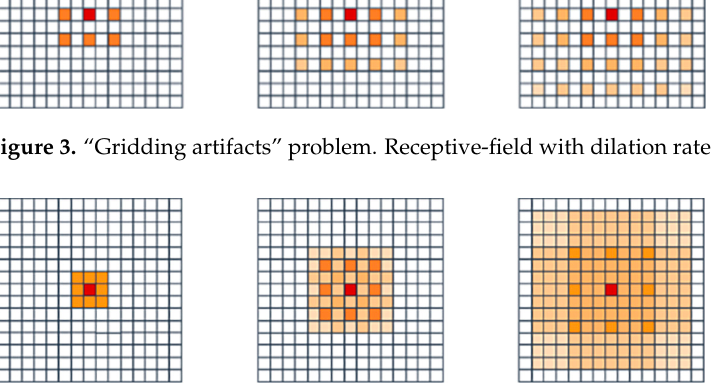
Figure 5. HDC Block. The HDC block consists of three convolution layers with kernel size 3 and dilation rates of r = 1, 2, 3, respectively, three batch normalization layers, and three ReLU activation functions. 2.4. Edge-Gated Layer Gated convolution solves the problem of traditional convolutional methods that treat all the pixels as equally important; the gated convolution layer (GCL) is capable of filtering irrelevant information and focus on partial information by providing a selection mechanism. Motivated by this, we introduced a gated layer to our work. The edge gated layer receives the inputs from its previous gated layer outputs with the corresponding resolution feature maps of the main stream. GCL enables collaboration between two streams. The regular stream has a high ability to extract high-level semantic information; GCL deactivates the features from each resolution feature map of the regular stream. In this work, edge ground truth was generated by leveraging a Canny filter [18,19] to the original vessel wall images’ ground truth masks. Let i be the number of convolutional layers, i ϵ 0, 1, …, j. Where 𝑟 (cid:3036) and 𝑒 (cid:3036) represent the inputs from resolution i of the regular stream and edge stream, respectively. We obtained an attention map 𝛼 (cid:3036) ∈ ℝ (cid:3009)(cid:3400)(cid:3024) by feeding 𝑟 (cid:3036) and 𝑒 (cid:3036) into a 1 × 1 convolutional layer, 𝐶 (cid:2869)(cid:3400)(cid:2869) , then concatenating them and passing them into a rectified linear unit (ReLU) [20] activation function. 𝛼 (cid:3036) = 𝜎 (cid:4672)𝑅𝑒𝐿𝑈(cid:3435)𝐶 (cid:2869)(cid:3400)(cid:2869) (𝑒 (cid:3036) ) + 𝐶 (cid:2869)(cid:3400)(cid:2869) (𝑟 (cid:3036) )(cid:3439)(cid:4673)